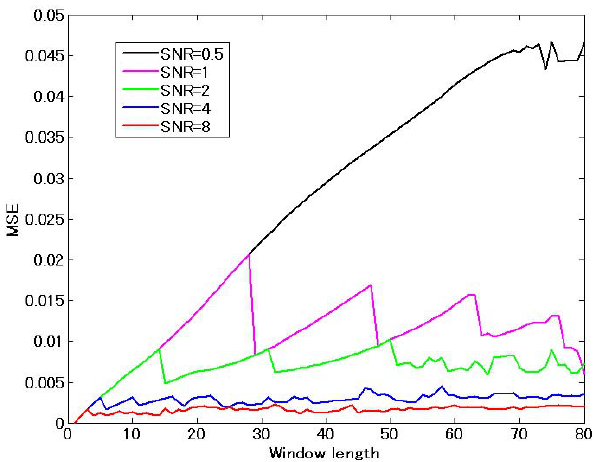
Fig. 11. The variation of MSE with the WL for various SNRs.